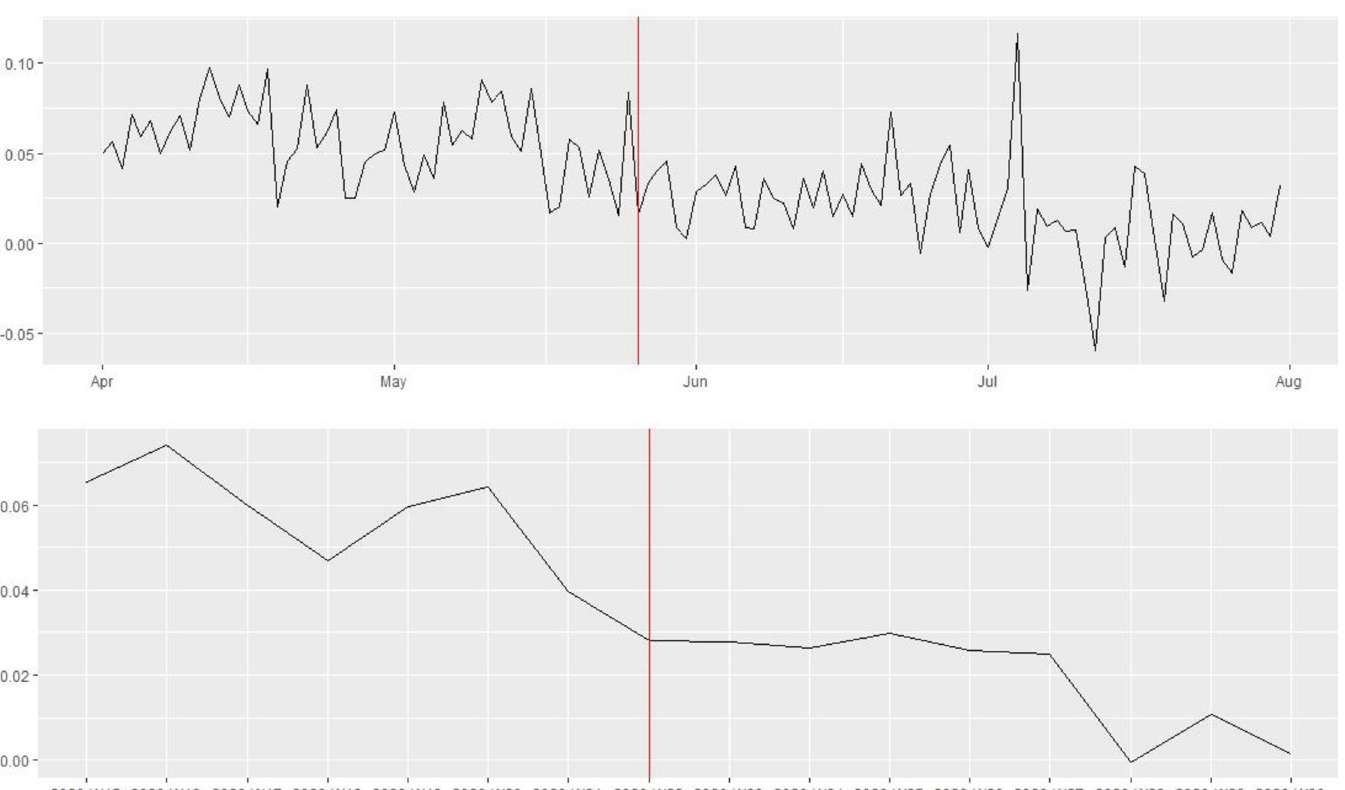
Fig 5. Emotional valence in the tweets of the 115 major police departments in the U.S. before and after the killing of George Floyd on May 25 th , 2020 (above: Daily information; bottom: Weekly information).